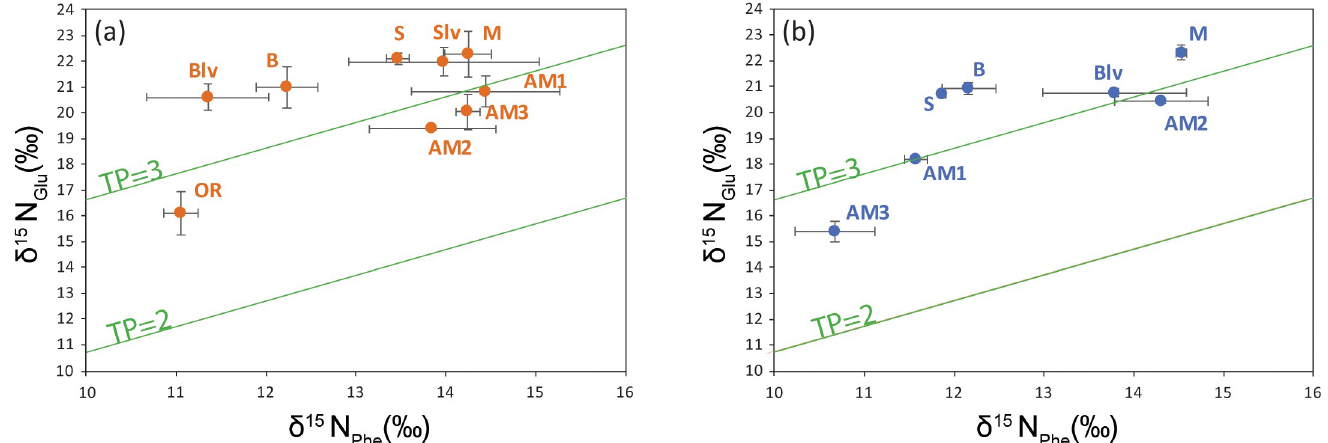
Fig 4. Calculated trophic positions (TP) of the stygofaunal specimens studied under LR (a) and HR (b) conditions.